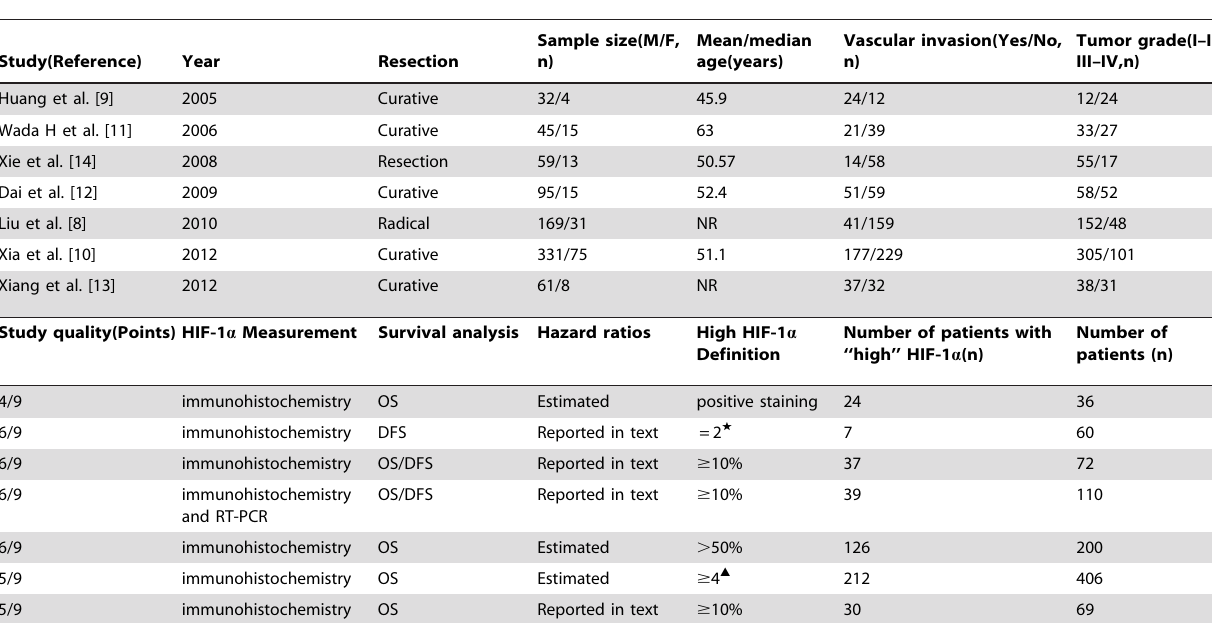
Table 1. Baseline characteristics of the studies in the meta-analysis.